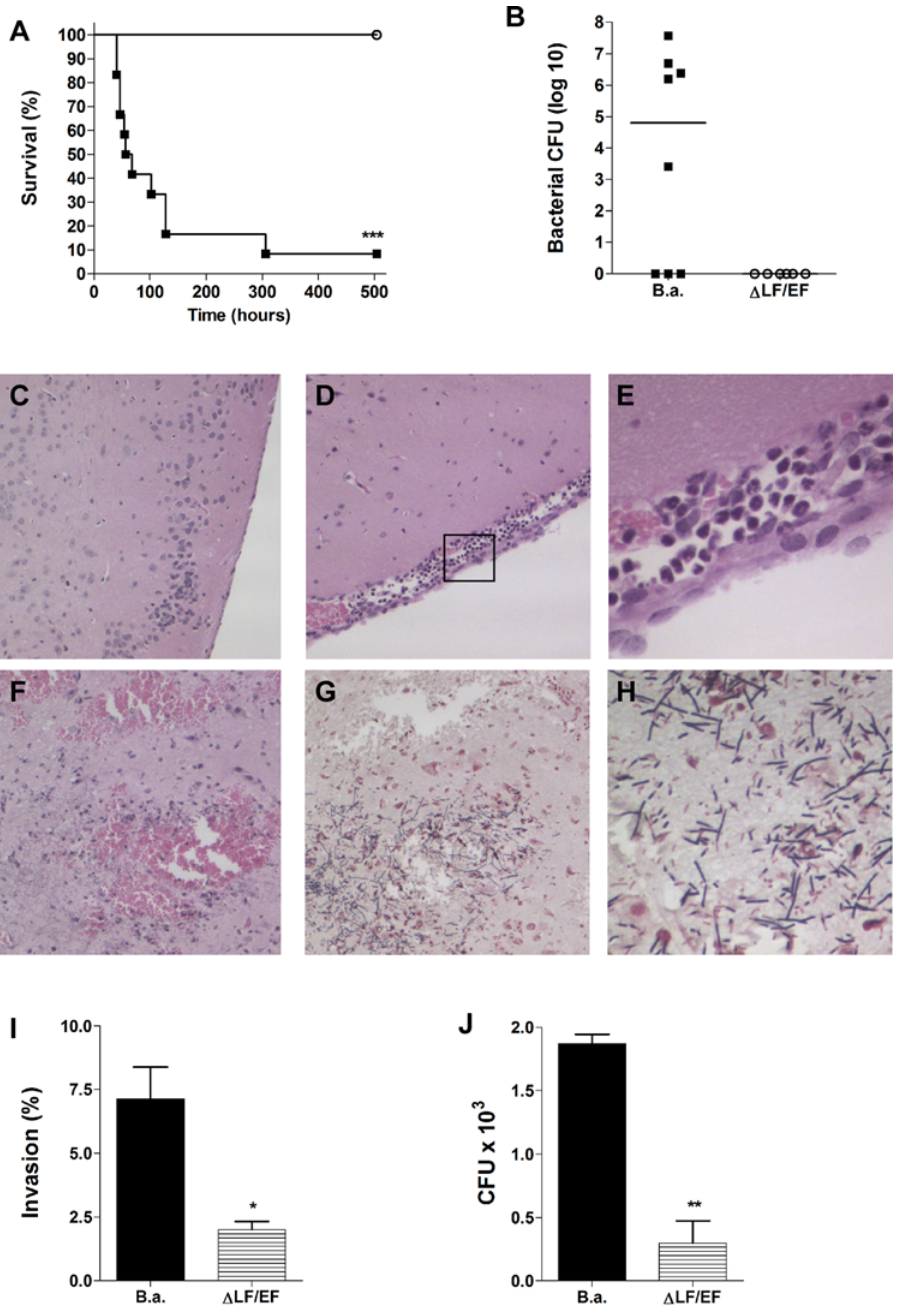
Figure 7. Mouse model of anthrax meningitis. (A) Kaplan-Meier survival curve of mice upon infection with B. anthracis Sterne (filled squares) or D LF/EF (open circles) bacteria. Groups of CD-1 mice (n=12 per group) were injected intravenously with 2–3 6 10 4 CFU of bacteria and survival was monitored at least twice a day over a three-week period. (B) Bacterial counts in brain at time of death of mice infected with B. anthracis Sterne (B.a.) or D LF/EF. Bar represents median bacterial number in the group of mice. Histopathology of ( C – F ) H&E- or ( G, H ) Gram-stained brain tissues of representative individual mice. ( C ) Sample from a mouse infected with D LF/EF bacteria showing normal brain architecture and no inflammation. Samples from mice infected with B. anthracis Sterne showing ( D, E ) meningeal thickening and cellular infiltration and ( F ) hemorrhaging. ( G, H ) Gram stain of a mouse infected with B. anthracis Sterne showing high levels of bacilli in the parenchyma. ( I ) Invasion and ( J ) transmigration of hBMEC by B. anthracis Sterne (B.a.) or D LF/EF bacteria. * p , 0.05; ** p , 0.005; *** p , 0.001.